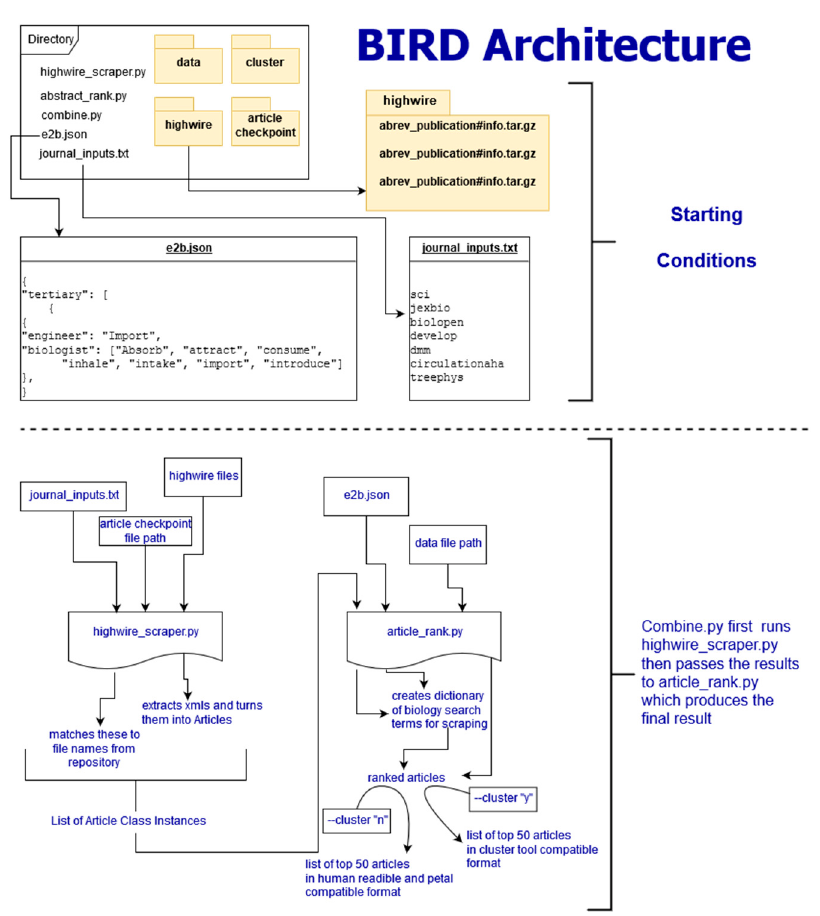
Figure 28. Bio-inspired research and design (BIRD) search interface.